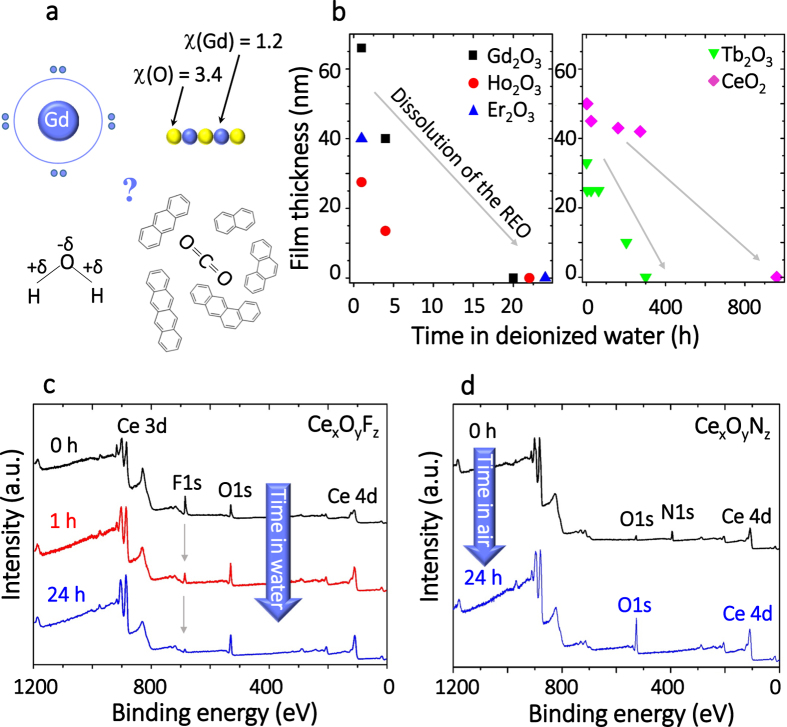
Reaction of RE oxides, oxy-fluorides, and oxy-nitrides with water.(a) Schematic illustration of the factors impacting the surface chemistry of RE oxide surfaces upon air exposure, regarding the origin of the earlier reported hydrophobicity1112. (b) Exposure of Gd, Ho, Tb, Er, Ce oxide films to 1 liter of deionized water leads to dissolution of the films as evidenced by the profilometer thickness and XPS measurements (Supplementary Fig. S1). This data confirms the ionic nature of the RE oxides, which are prone to dissolve in water. (c) Exposure of Ce oxy-fluoride films to 1 liter of deionized water leads first to the substitution of F by O and then to dissolution, as evidenced by XPS. Furthermore, Ce oxy-nitride undergoes substitution of N by O even without dipping into water, but only by being exposed to air for less than 24 h.